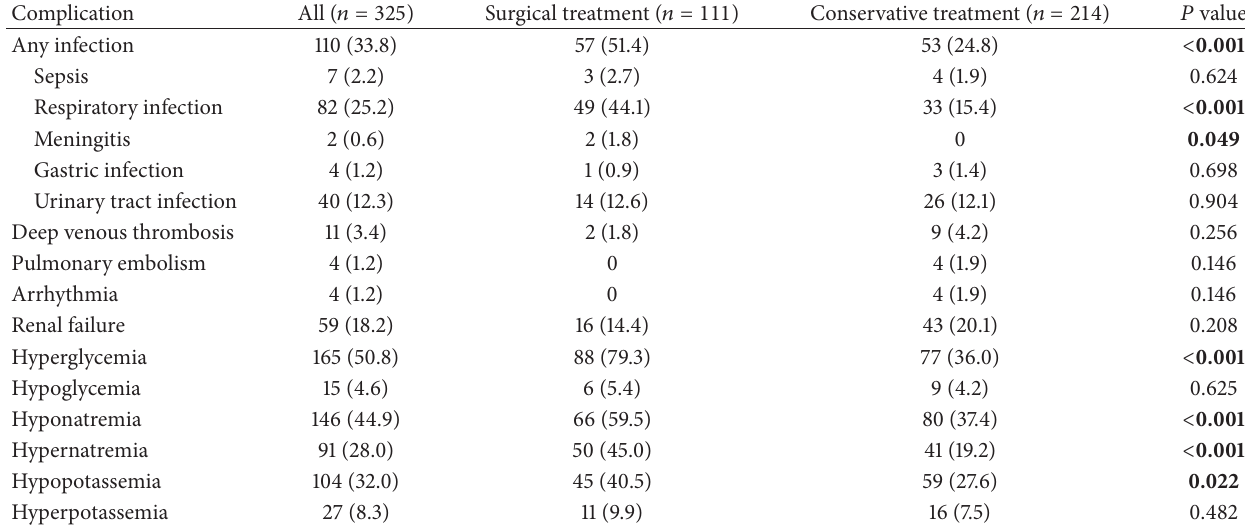
Table 2: Overview of in-hospital medical complications and conservative or operative treatment in 325 young patients with first-ever nontraumatic intracerebral hemorrhage.